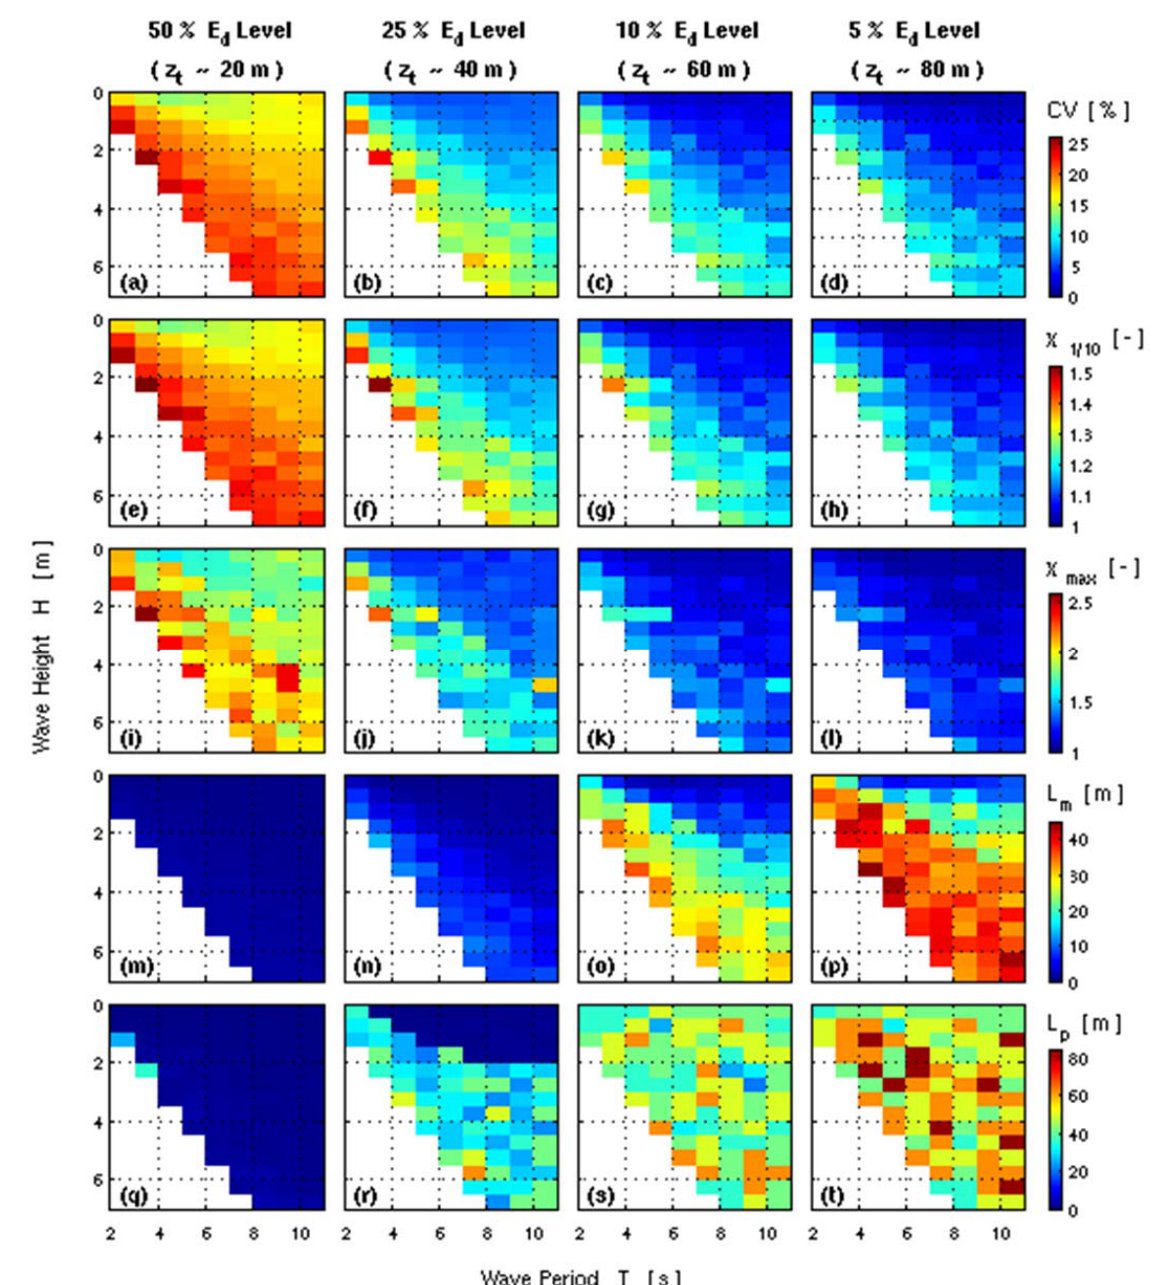
Fig. 9. Statistical characteristics of the influence of the sea states (Fig. 2) on the underwater irradiance variability at the 50, 25, 10, and 5% E d depth level ( z t =19.7, 38.5, 62.0, and 79.2m respectively) based on the model with dx =10cm resolution; (a) – (d) : coefficient of variation CV ; (e) – (h) : significant irradiance enhancement χ 1 / 10 ; (i) – (l) : maximum normalized irradiance χ max ; (m) – (p) : mean fluctuation length L m ; (q) – (t) : spectral peak length L p.